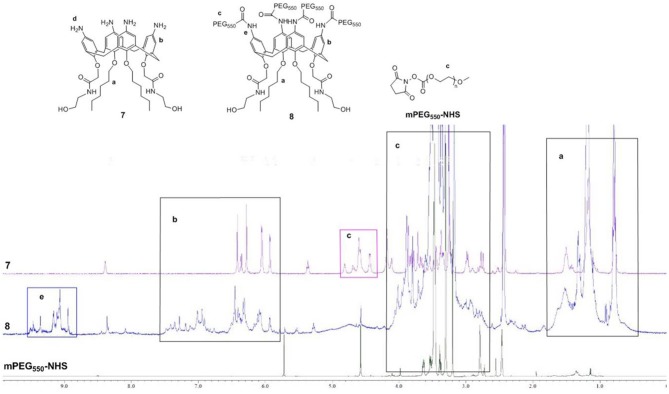
1H NMR spectrum comparison of calixarene derivative 7, 8, and mPEG550-NHS.